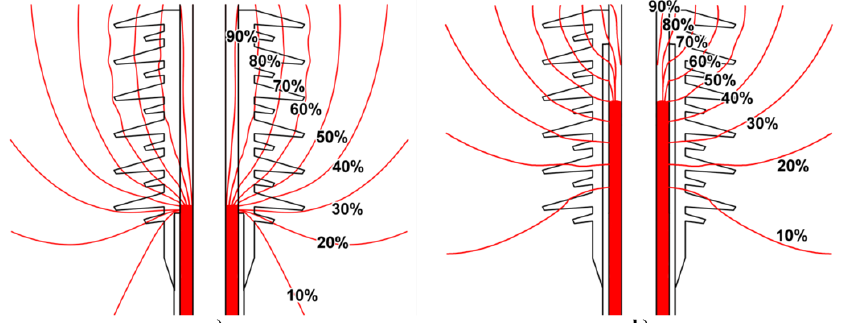
Figure 52. Equipotential line distribution under applied voltage (100 kV, AC): ( a ) EPDM-graded cable tube ( ε r = constant) and ( b ) nonlinear composite-graded cable tube. © 2021 IEEE. Reprinted, with permission, from [23].